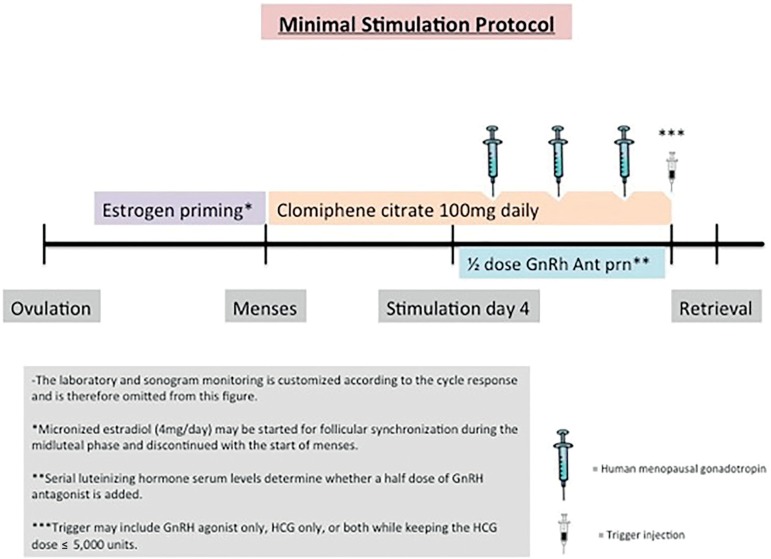
Minimal Stimulation IVF Protocol A visual representation of a commonly
used minimal stimulation IVF protocol